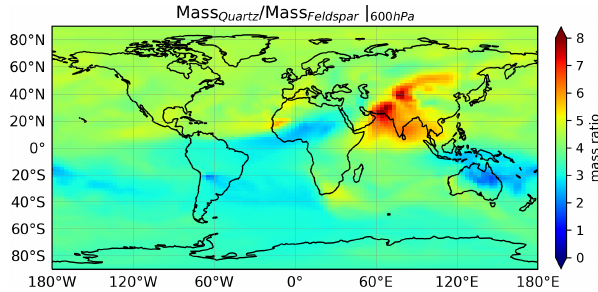
Figure 6. Annual mean ratio of quartz to feldspar mineral masses in dust, as calculated by dividing quartz mass by feldspar mass at